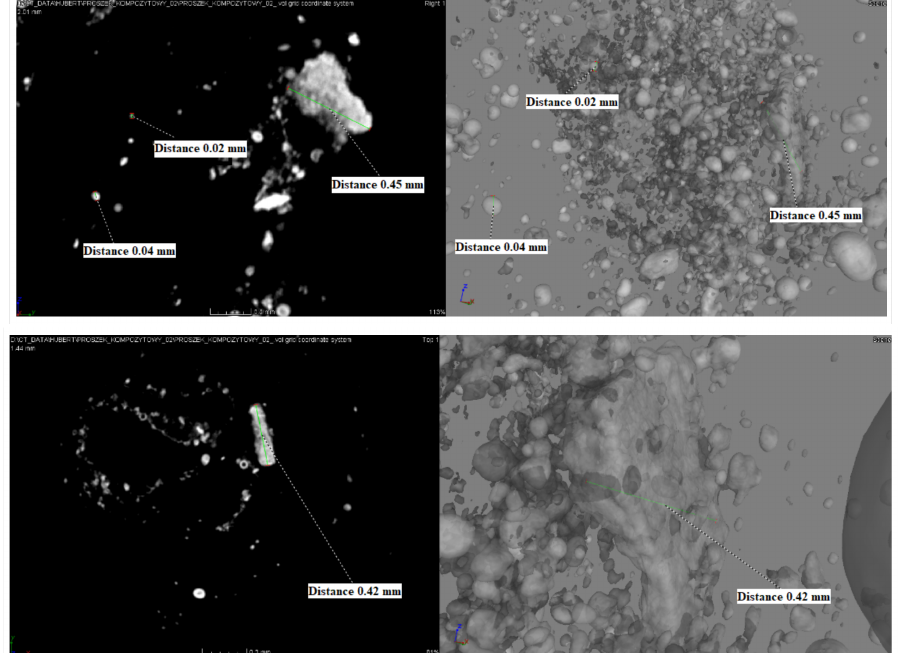
Figure 9. µ CT registered morphology of the Ni–P–ZrO 2 composite